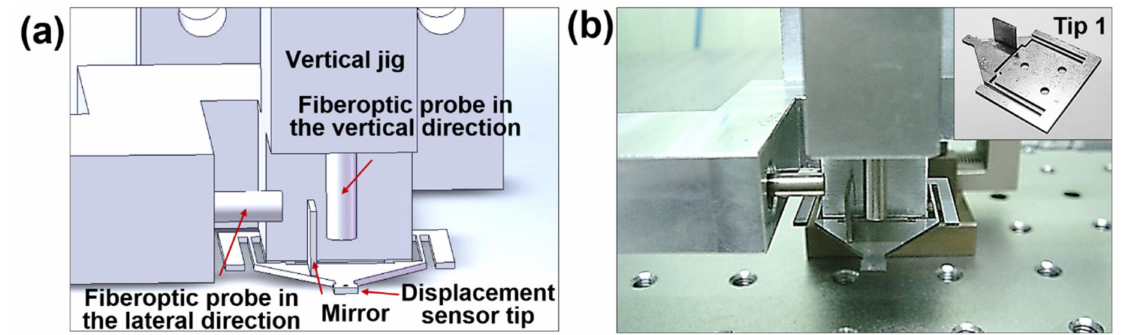
Figure 2. Experimental setup: ( a ) schematic design and ( b ) photo of the fiberoptic sensor–jig set and cantilever tip. Inset image ( b ): cantilever